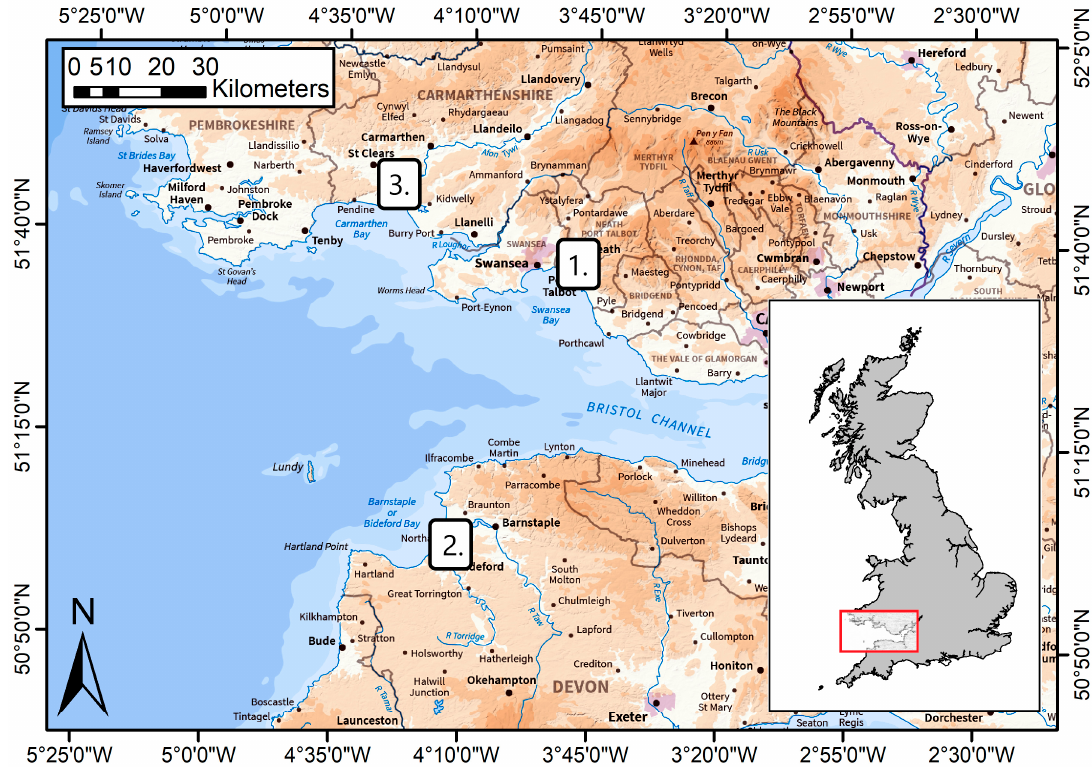
Figure 1. A map showing the location of the three study sites in S. Wales and SW England: ( 1 ) Neath Estuary; ( 2 ) Appledore; and ( 3 ) Llansteffan. The inset shows the location of the main map with respect to the rest of the UK.